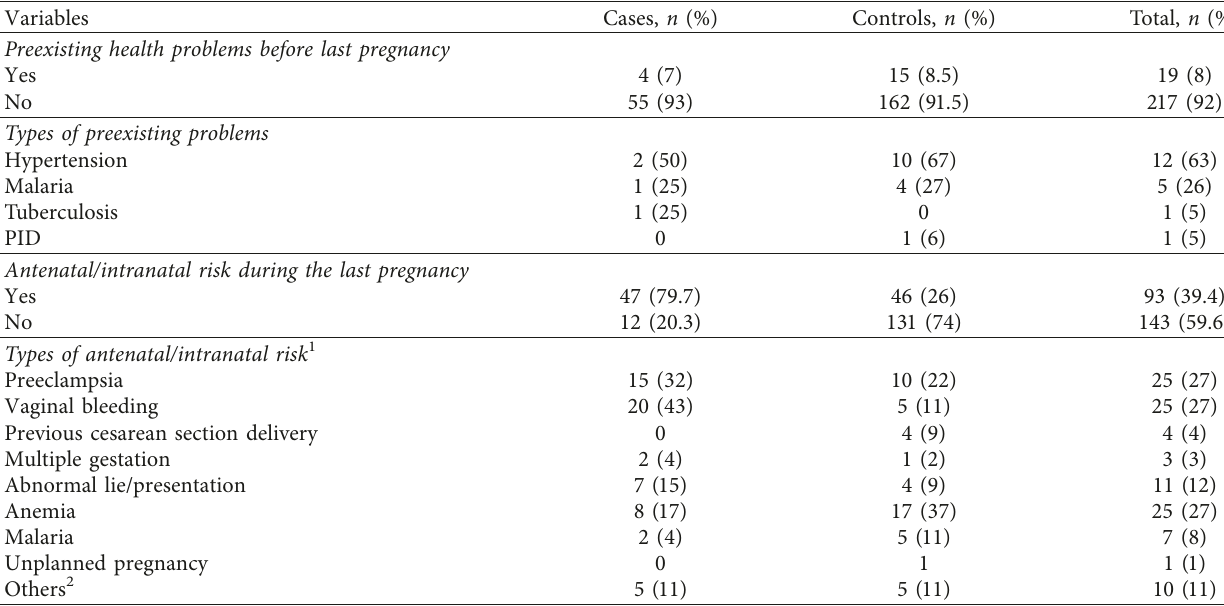
Table 4: Preexisting problems and/or antenatal/intranatal risk during the last child pregnancy of pregnant women who delivered between September 2014 and March 2017 at pastoralist area of Borena zone, Oromia region, Ethiopia.